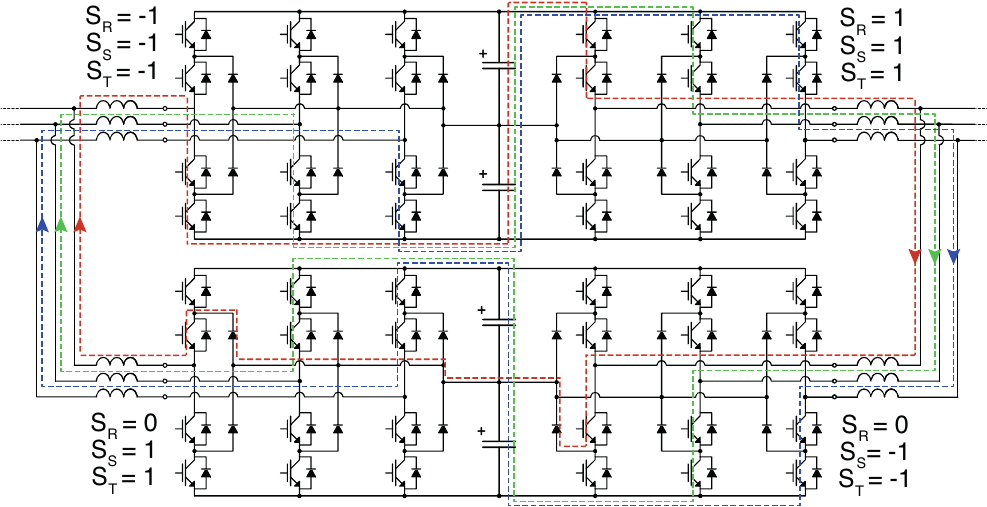
Figure 3. Circulating current generation